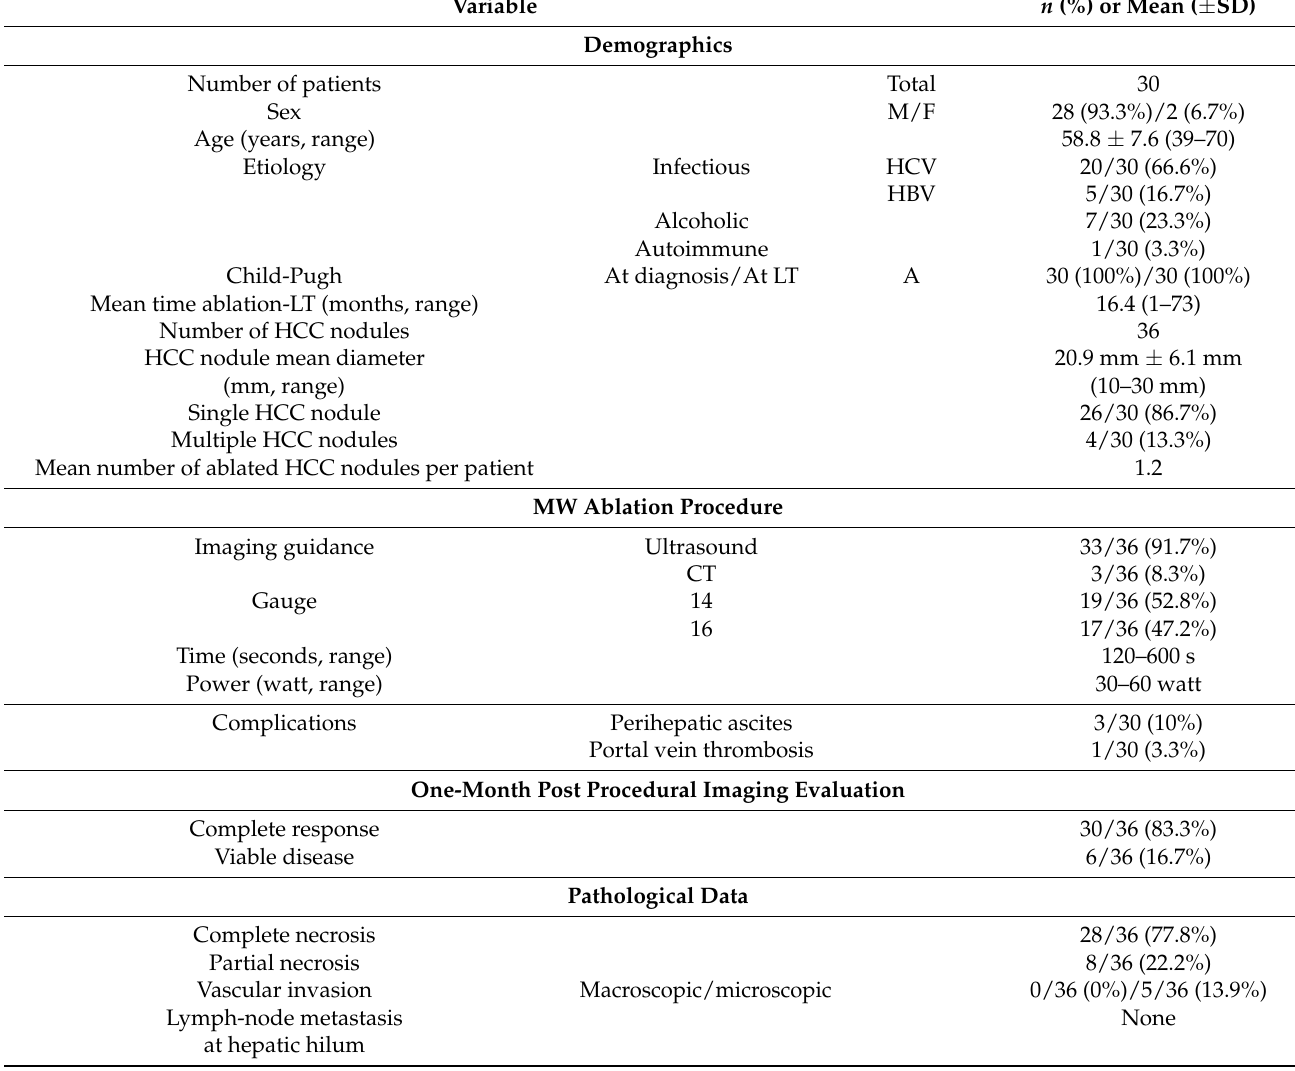
Table 1. The demographic, procedural and pathological